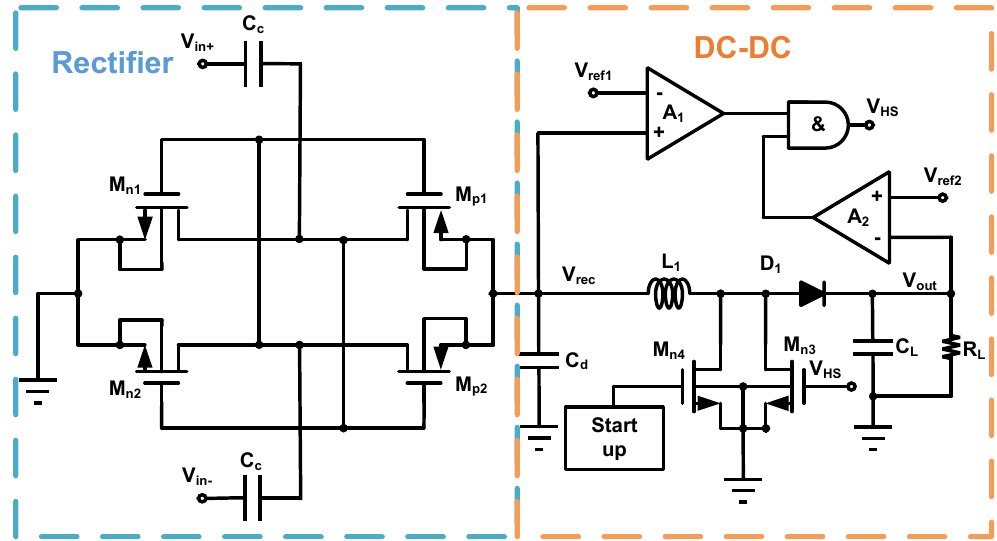
Figure 10. RF rectifier and DC-DC boost converter with maximum power point tracking